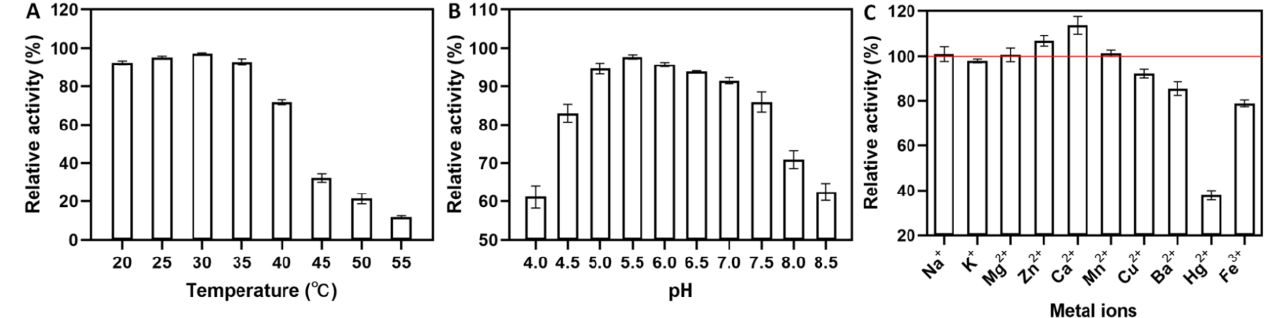
Figure 1. Enzymatic properties of Ln. pseudomesenteroides glucansucrase. ( A ) Temperature stability; ( B ) pH value stability; ( C ) metal ions stability. ( B ) pH value stability; ( C ) metal ions